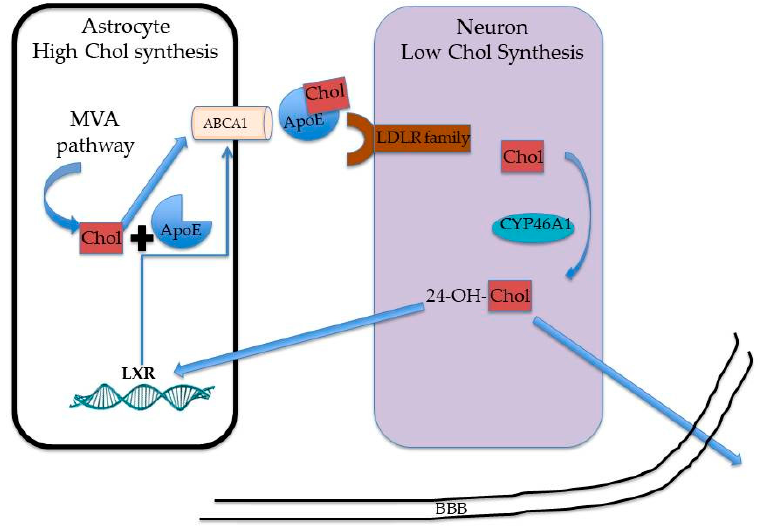
Figure 2. Schematic representation of cholesterol interplay between astrocytes and neurons.